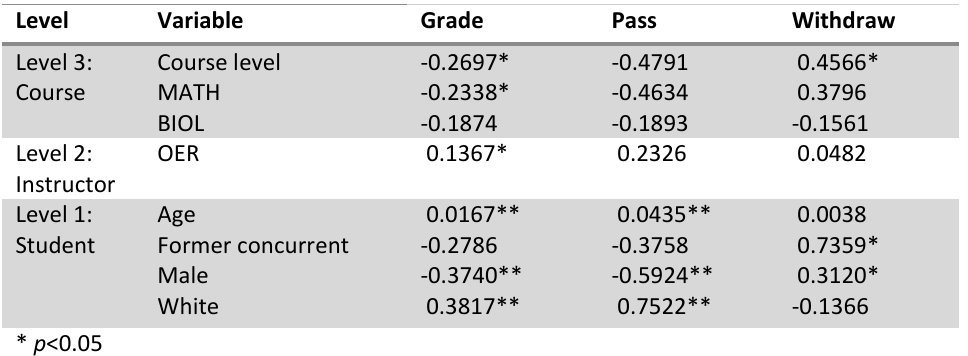
Figure 10. Results – New